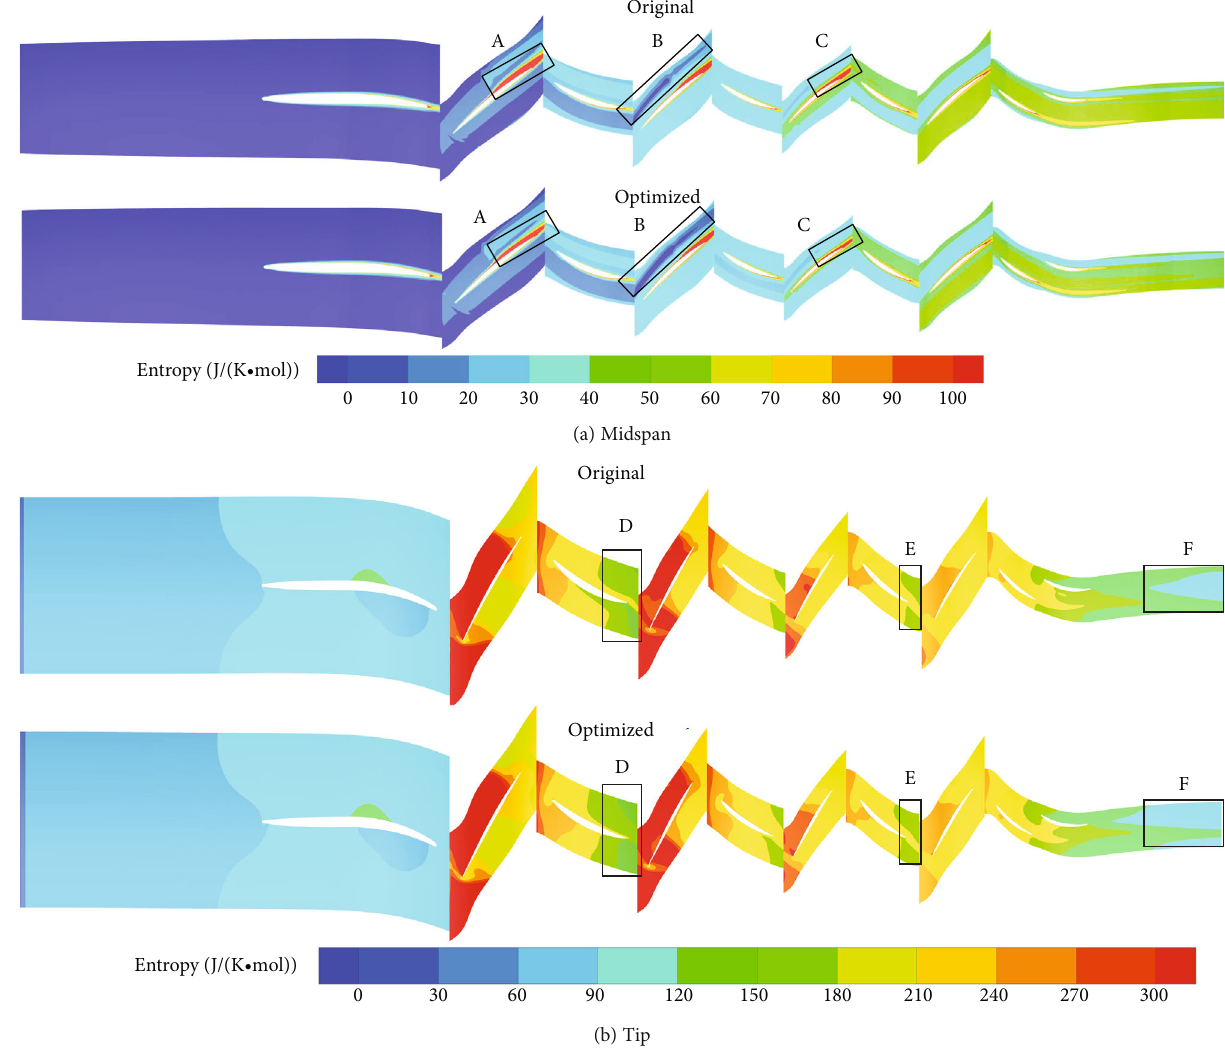
Figure 18: Comparison of entropy distribution at the midspan and tip section before and after